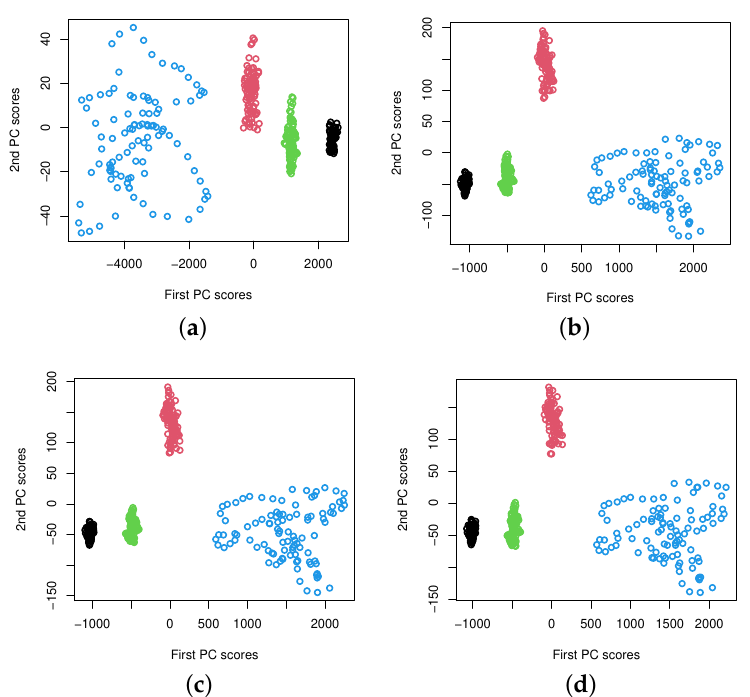
Figure 4. The plots of extracted two-dimensional principal component scores of DWT power spectra for data sets A (Normal: Eyes Closed, Black), B (Normal: Eyes Open, Red), C (Non-epileptogenic zone, Green) and D (Epileptogenic zone, Blue) respectively, with different values of K , the number of basis functions. ( a ) K = 4, ( b ) K = 5, ( c ) K = 6, ( d ) K = 7.